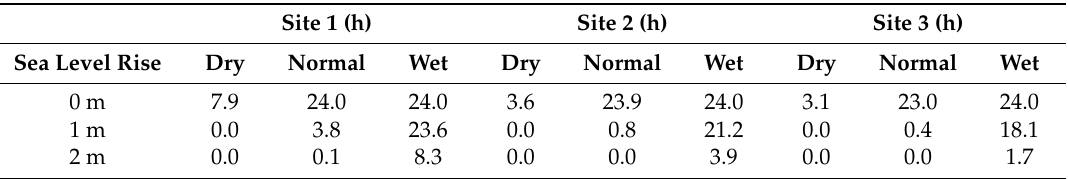
Table 4. Modelled time duration (no. of hours) below salinity criterion of 0.34 ppt at site 1, site 2, and site 3 with various sea level rises and types of flow year. Site 1 (h) Site 2 (h) Dry Normal Dry